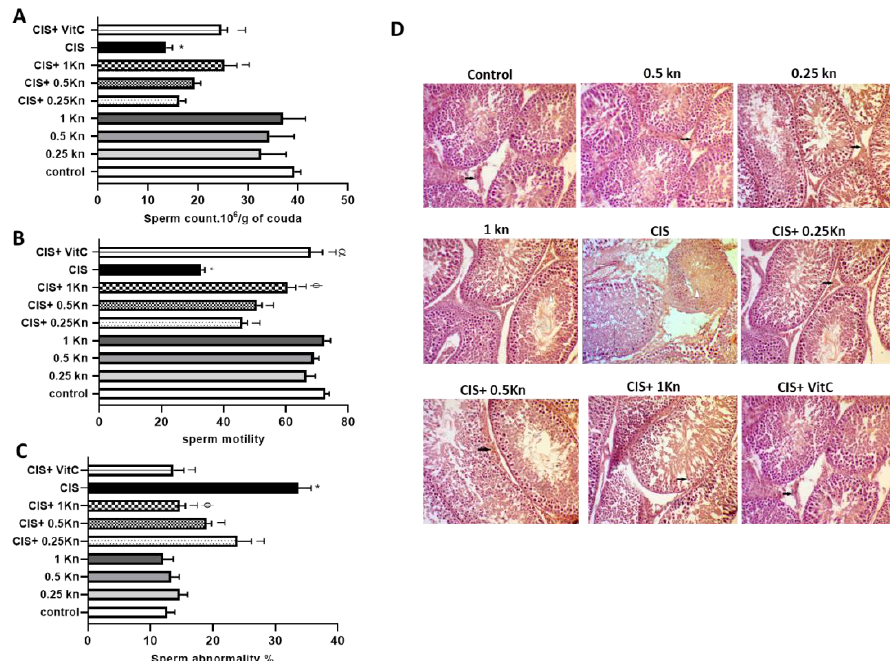
Figure 2. Effect of different doses of kinetin and vitamin C on ( A ) sperm count, ( B ) sperm motility, ( C ) sperm abnormality, and ( D ) histopathological changes in cisplatin treated rats ( × 200). Data are represented as mean ± SEM, *,T, ф and α are significant differences from control, 0.25 Kn, CIS, CIS+ 0.25 Kn and CIS+ 1 Kn groups, respectively, at p < 0.05 where n = 5 – 6. Kn, kinetin; CIS, cisplatin; VitC, vitamin C.